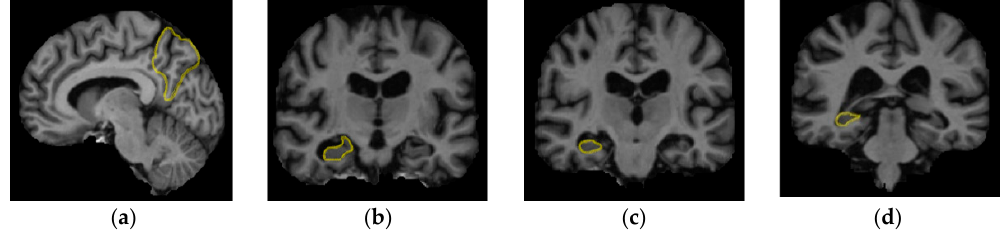
Figure 1. The regions of interest (outlined using yellow color) illustrating the boundaries of the left precuneus ( a ) in the sagittal plane and right hippocampus ( b ) head ( c ) body and ( d ) tail.